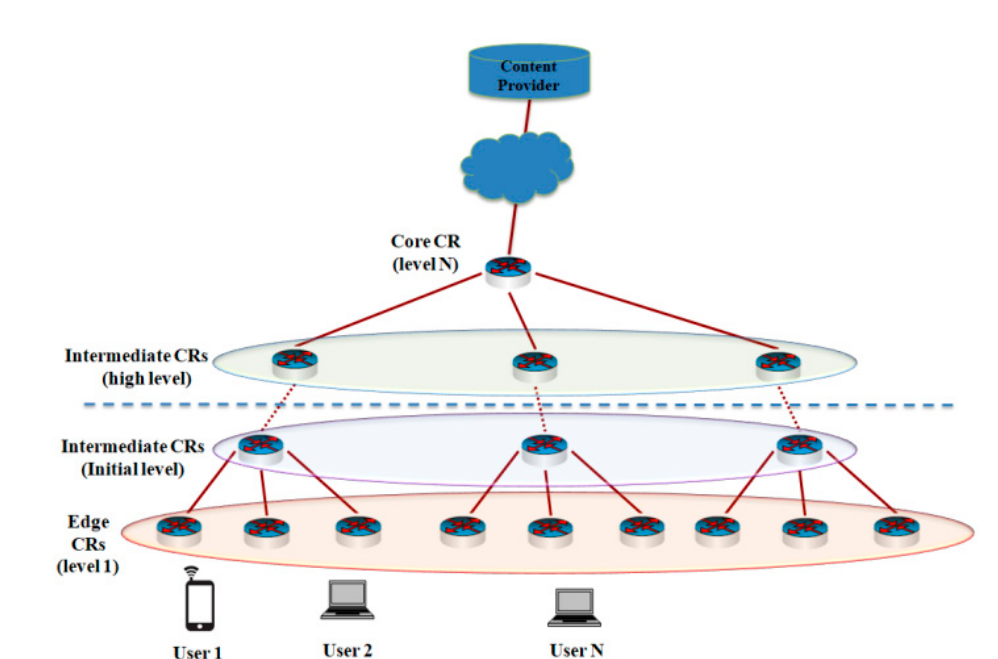
Figure 1. Hierarchical network topology for PPCS.